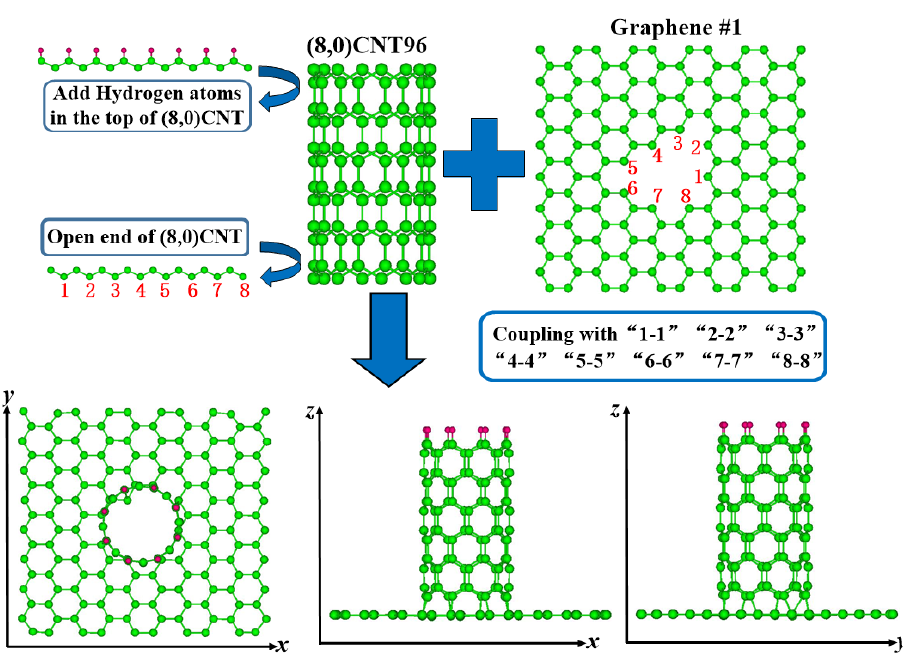
Figure 2. Schematic diagrams of initially constructed (8,0)CNT-graphene configurations #1 structures.